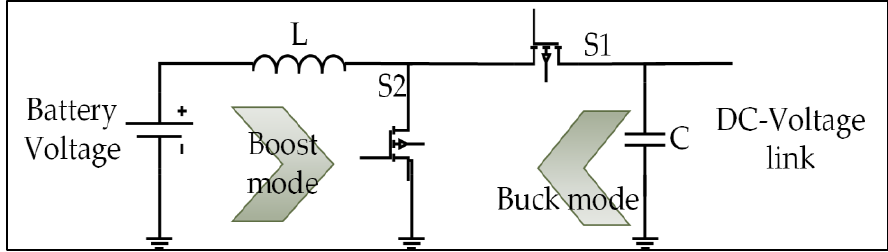
Figure 2. A bidirectional DC – DC buck – boost converter equivalent circuit model.